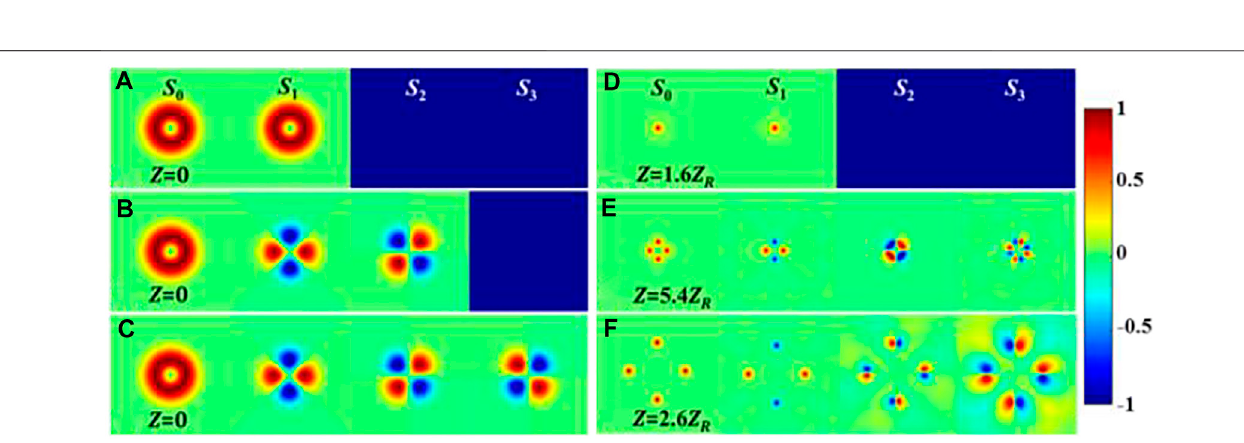
Frontiers in Physics |